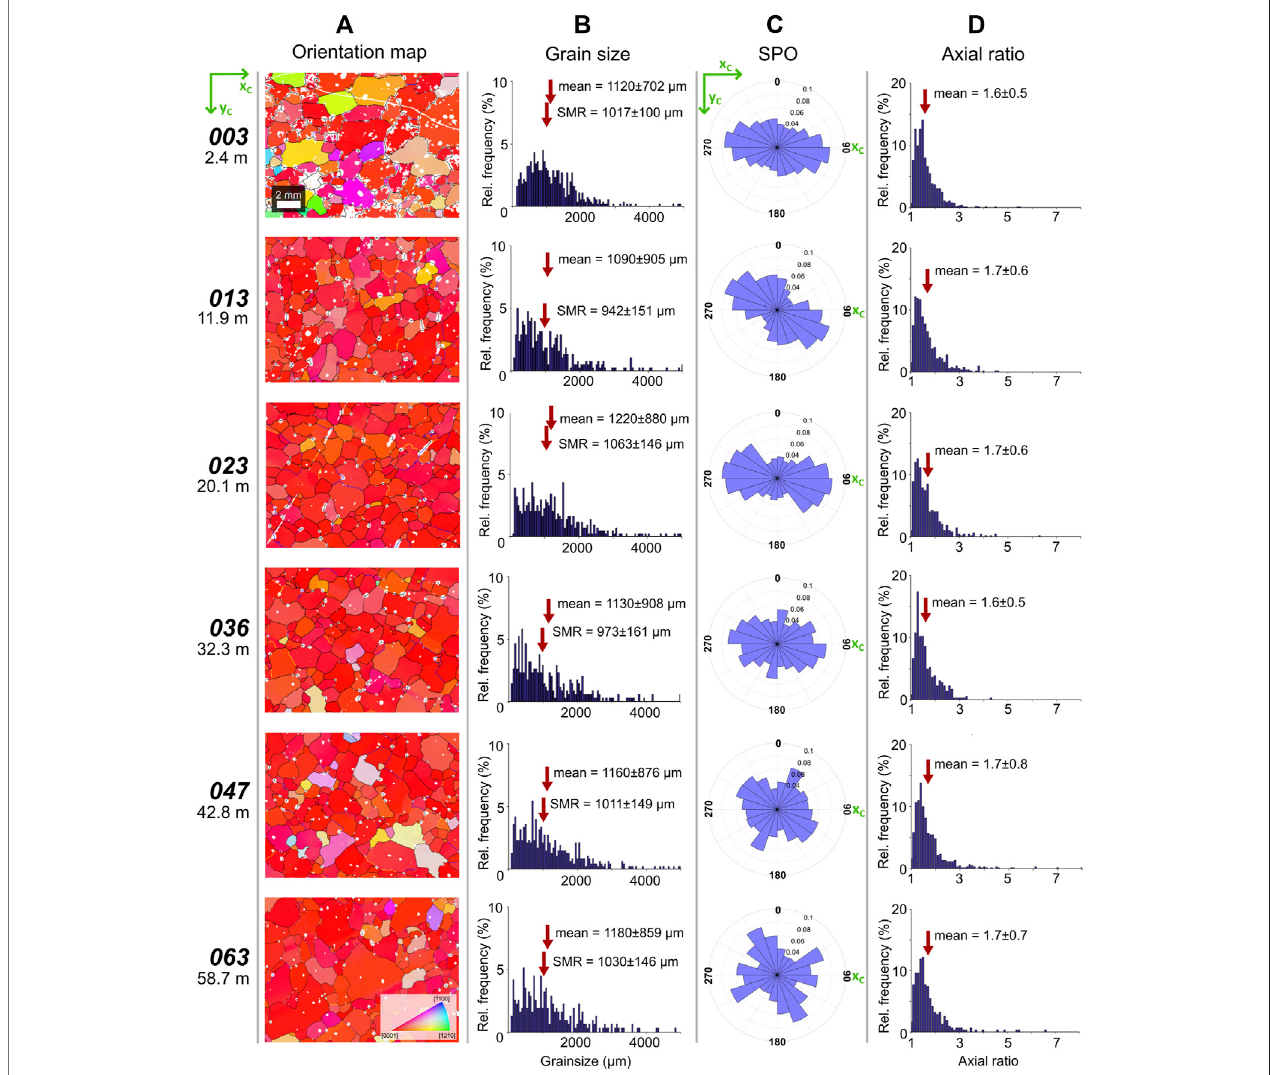
FIGURE8| MicrostructureofsixrepresentativesamplesalongthePriestleyGlaciericecore. (A) Orientationmapscoloredbycrystallographicorientationparallelto the xC axis. Step size is 20 µm. Grain boundaries are black, characterized by a misorientation of 10 ° , while yellow and blue subgrain boundaries are characterized by a misorientation of 3 and 5 ° , respectively. (B) Grain size distributions. (C) Shape preferred orientations of grains in the “ c -axis maximum ” reference frame. The height of each bar is the relative number of orientations. (D) Grain axial ratio distributions.